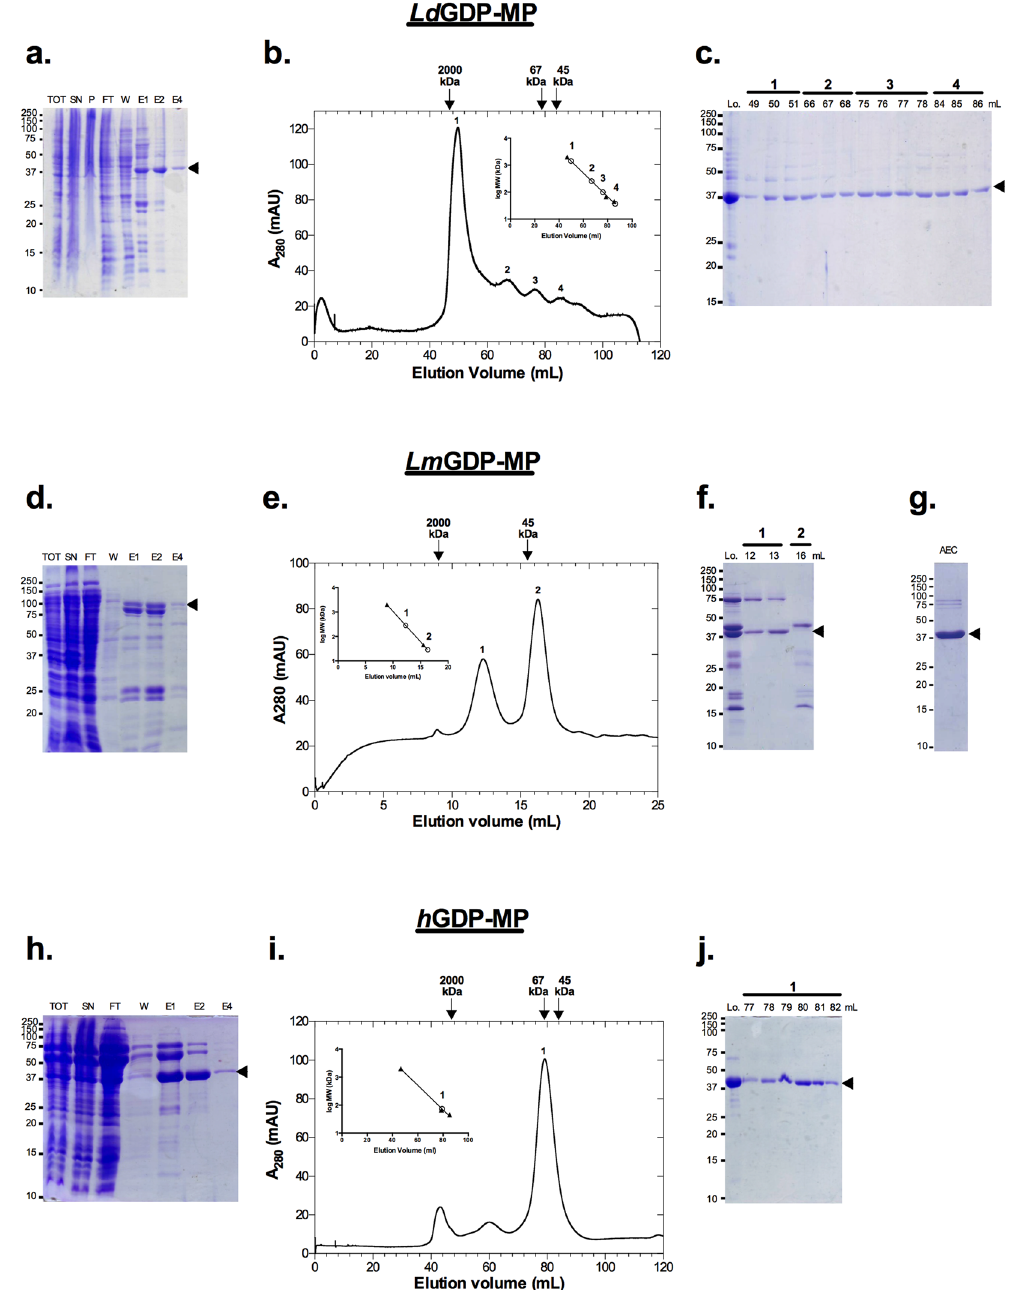
Figure 1. Purification of Ld GDP-MP, Lm GDP-MP and h GDP-MP. ( a,d,h ) Coomassie blue stained SDS-PAGE of Ld GDP-MP ( a ), Lm GDP-MP ( d ), and h GDP-MP ( h ) purified from Ni-NTA column. Lane TOT: total, Lane SN: supernatant, Lane P: Pellet, Lane FT: flow through, Lane W: wash, Lanes E1, E2 and E4: elution fraction at 100 µ M, 200 µ M and 400 µ M imidazole, respectively. The arrowheads show the proteins of interest. The protein ladders on the left are indicated in kDa. Full length gels are presented in Supplementary Fig. S7. ( b,e,i ) Size exclusion chromatography profiles of Ld GDP-MP ( b ), Lm GDP-MP ( e ), and h GDP-MP ( i ). In the inset, the filled triangles and open circles represent standard proteins and the peaks of proteins of interest, respectively. ( c,f,j ) Coomassie blue stained SDS-PAGE of fraction volumes of peaks 1 (49–51 mL), 2 (66–68 mL), 3 (75–78 mL) and 4 (84–86 mL) of Ld GDP-MP ( c ), peaks 1 (12–13 mL) and 2 (16 mL) of Lm GDP-MP ( f ) and peak 1 (77–82 mL) of h GDP-MP ( j ). Lo is the loading control. The arrowheads show the proteins of interest. The protein ladder on the left is indicated in kDa. Full length gels are presented in Supplementary Fig. S7. ( g ) Coomassie blue stained SDS-PAGE of a concentrated pool of fractions containing Lm GDP-MP eluted from anion exchange chromatography (AEC). The arrowhead shows the protein of interest. The protein ladder on the left is indicated in kDa. Full length gel is presented in Supplementary Fig.